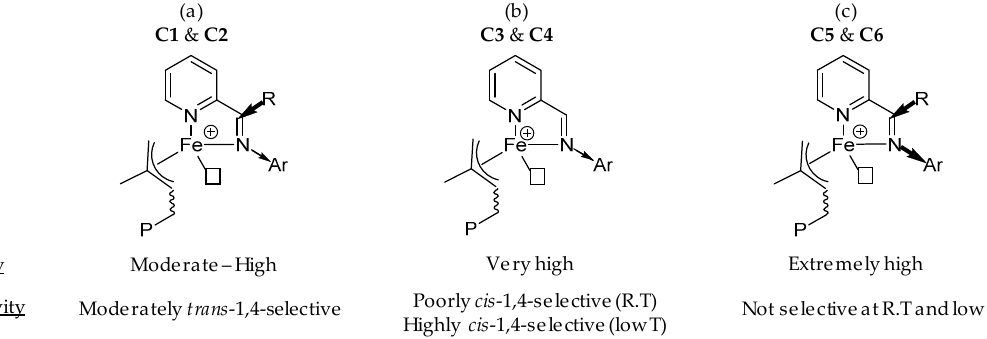
Figure 7. Structure-properties relationships in iminopyridyl iron-based catalysts issued from ( a ) ketiminopyridyl C1 – C2 , ( b ) aldiminopyridyl C3 – C4 and ( c ) fluoroaryl-ketiminopyridyl C5 – C6 .